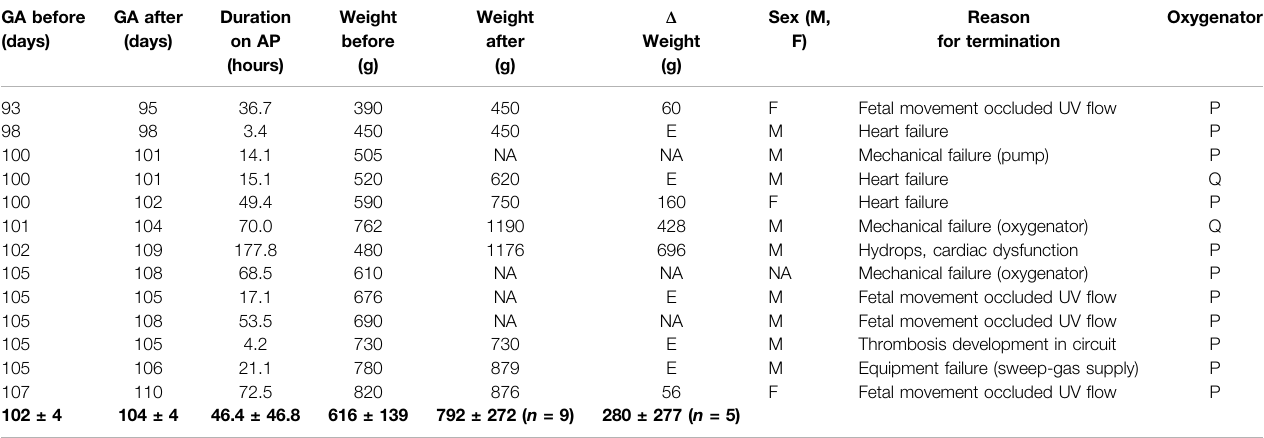
The bold letters represent MEAN ± SD. NA,notavailable;M,male;F,female;GA,gestationalage;E,excludedfrom Δ weightanalysis;P,ParagonneonatalcommerciallyavailableECMOoxygenator;Q,Quadrox-Icommercially available bypass oxygenator.